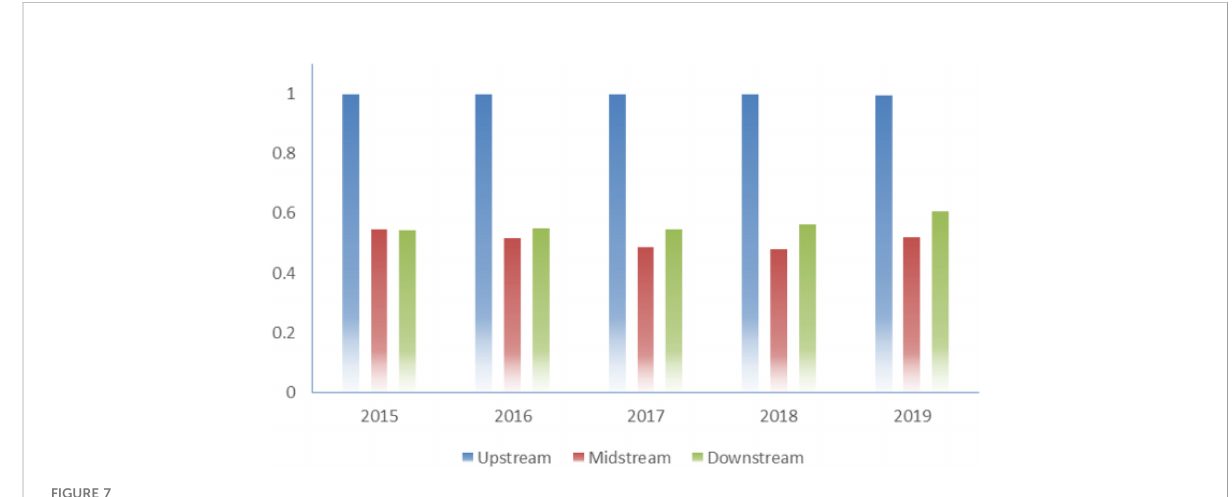
FIGURE 7 TGR for each link of the industry chain after adjustment,